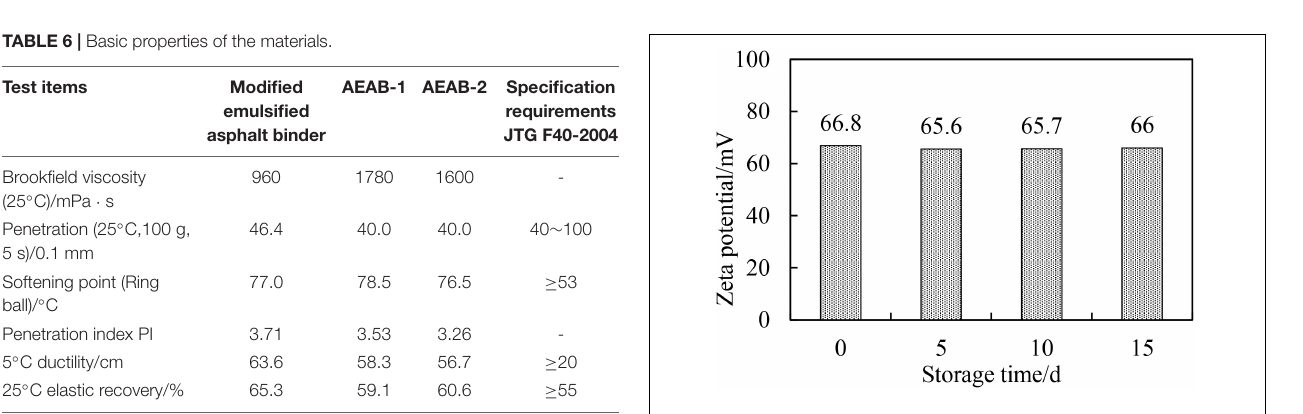
FIGURE 3 | Bonding test: (A) Testing device. (B) The Marshall specimen with a polished surface. (C) The testing schematic. (D) The prepared specimen.